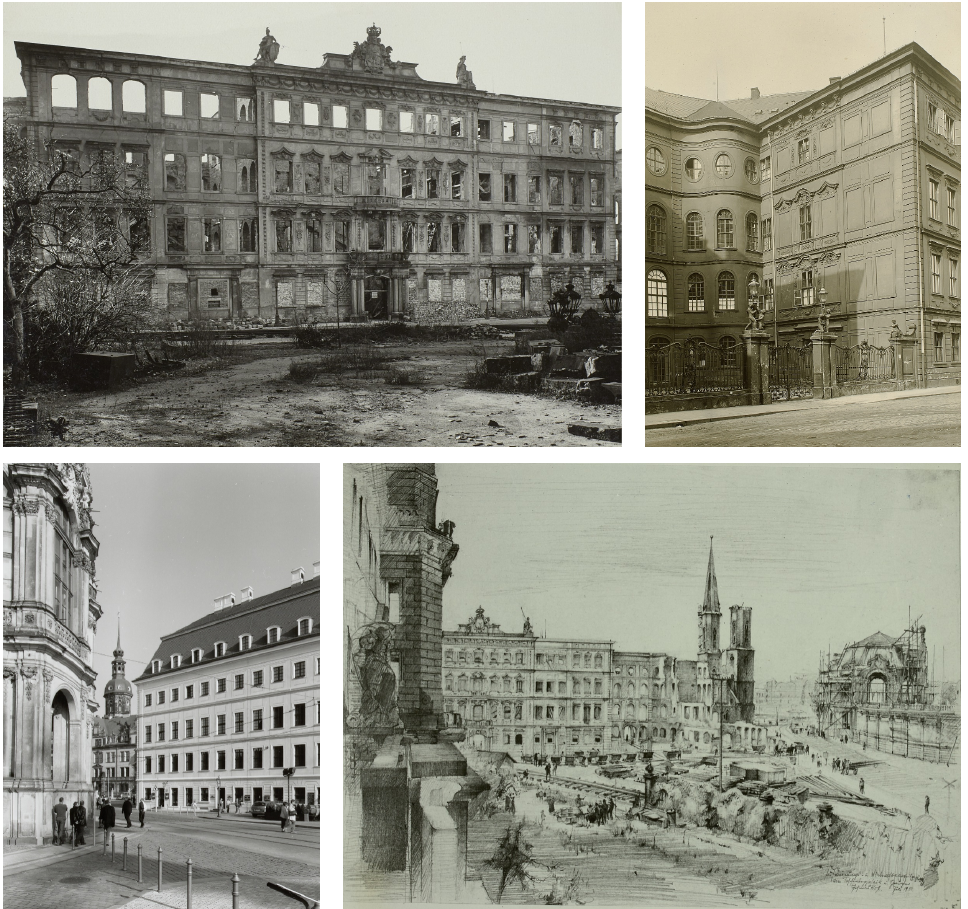
Figure 8. Four images of Taschenbergpalais that are retrieved by LEA. The automatic SfM reconstruc- tion in COLMAP reveals the correct camera orientation for three images, while the bottom left image is incorrectly matched and oriented due to the repeating pattern of the